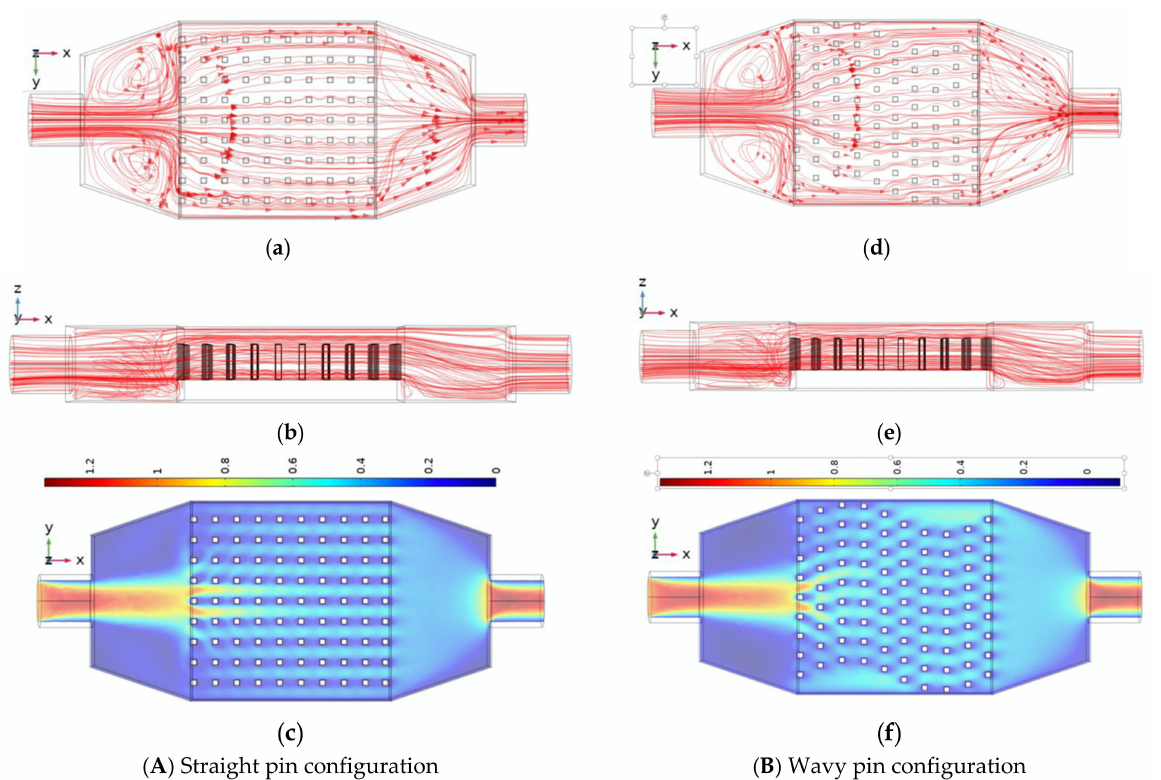
Figure 6. Flow distributions for the pin configurations. (Re = 250, pin-fin height 6 mm, ( a ) Streamline in (xy) plane, ( b ) Streamline in (xz) plane, ( c ) Velocity in (xy) plane, ( d ) Streamline in (xy) plane, ( e ) Streamline in (xz) plane, ( f ) velocity in (xy)